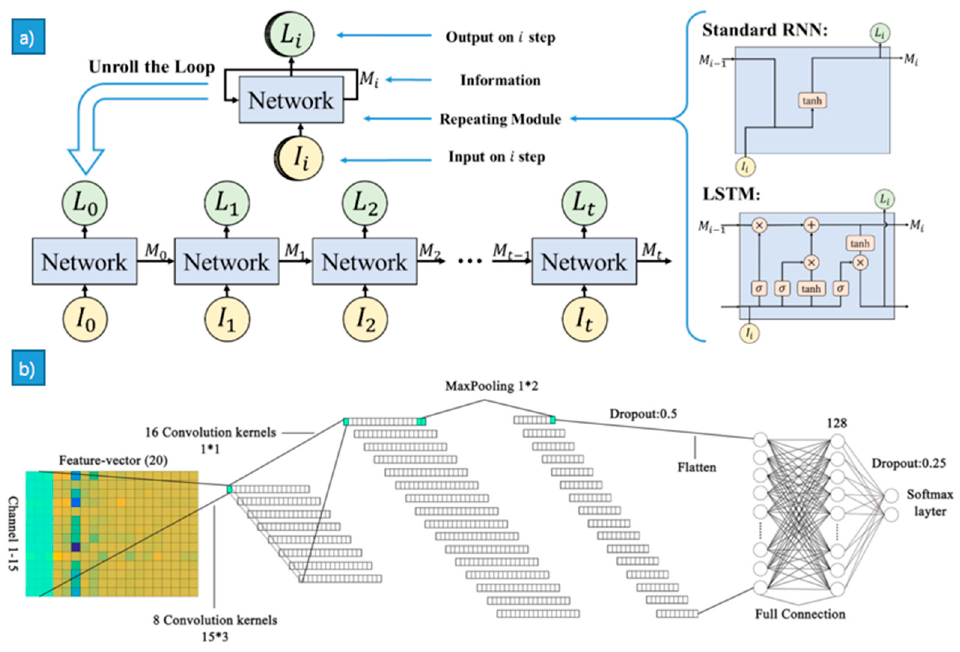
Figure 14. ( a ) The structure of standard RNN and LSTM; ( b ) The structure and settings of CNN. DBN